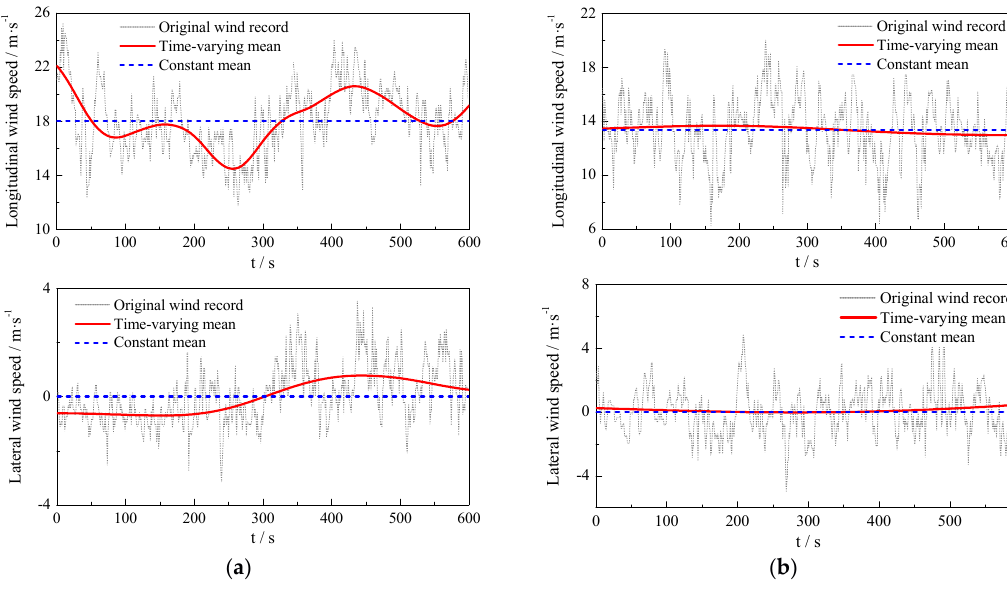
Figure 5. Time-varying mean wind speed versus constant mean wind speed of wind records: ( a ) non-stationary records; ( b ) stationary records.